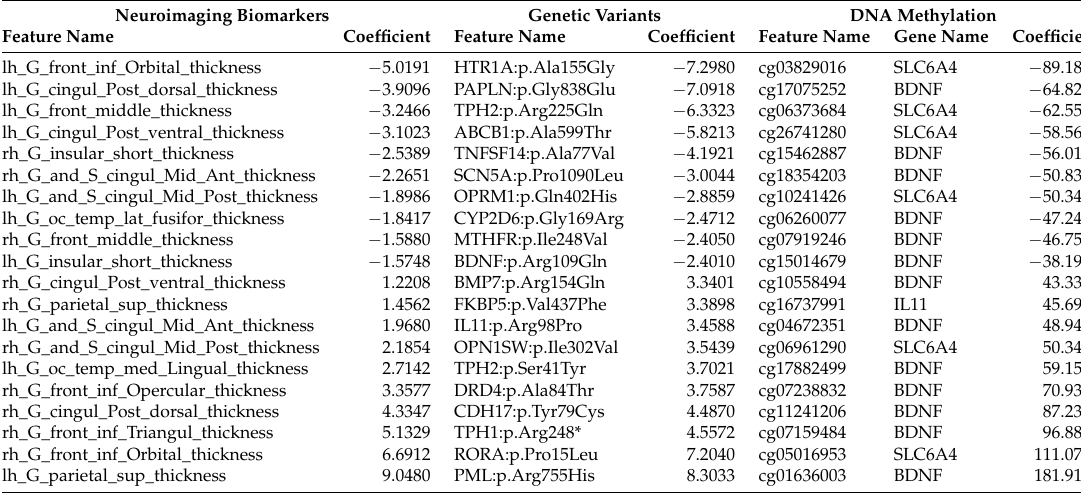
Table 1. Selected